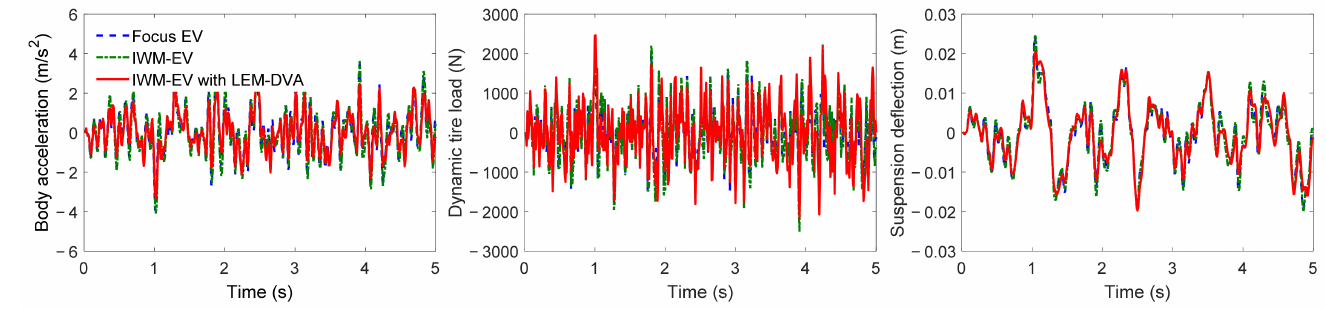
Figure 11. Dynamic performance comparison in the time